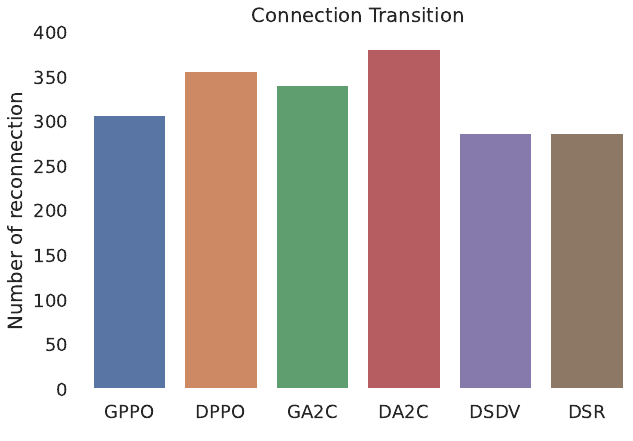
Figure 5. Number of